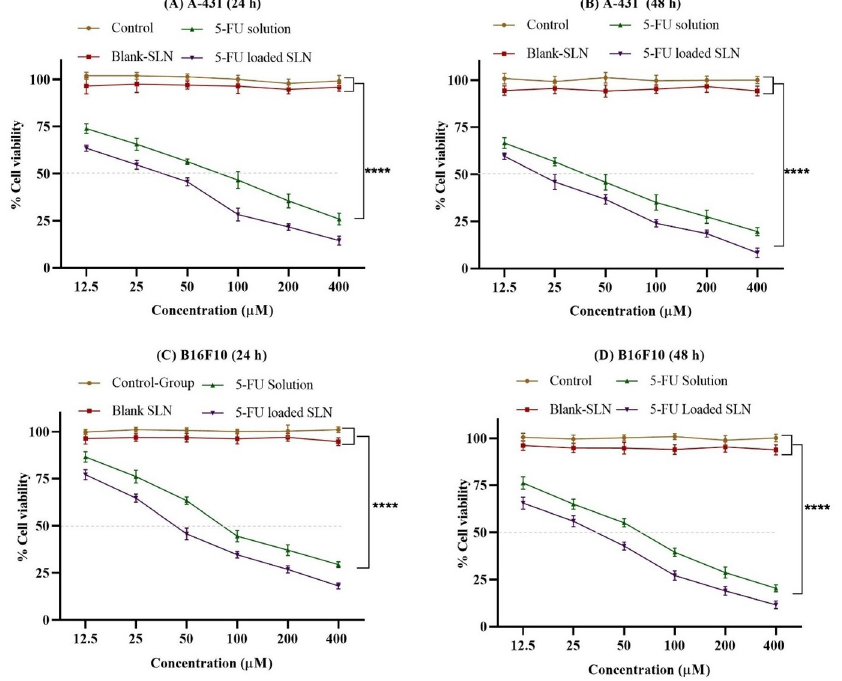
Fig 6. Cytotoxicity profile of blank SLN, 5-FU drug solution and 5-FU-loaded SLN on A-431 after 24 h (A), 48 h (B) and B16F10 after 24 h (C) and 48 h (D). All results indicate mean ± SD, n = 3, p ���� < 0.0001 (Two-way ANOVA with Tukey’s Post hoc